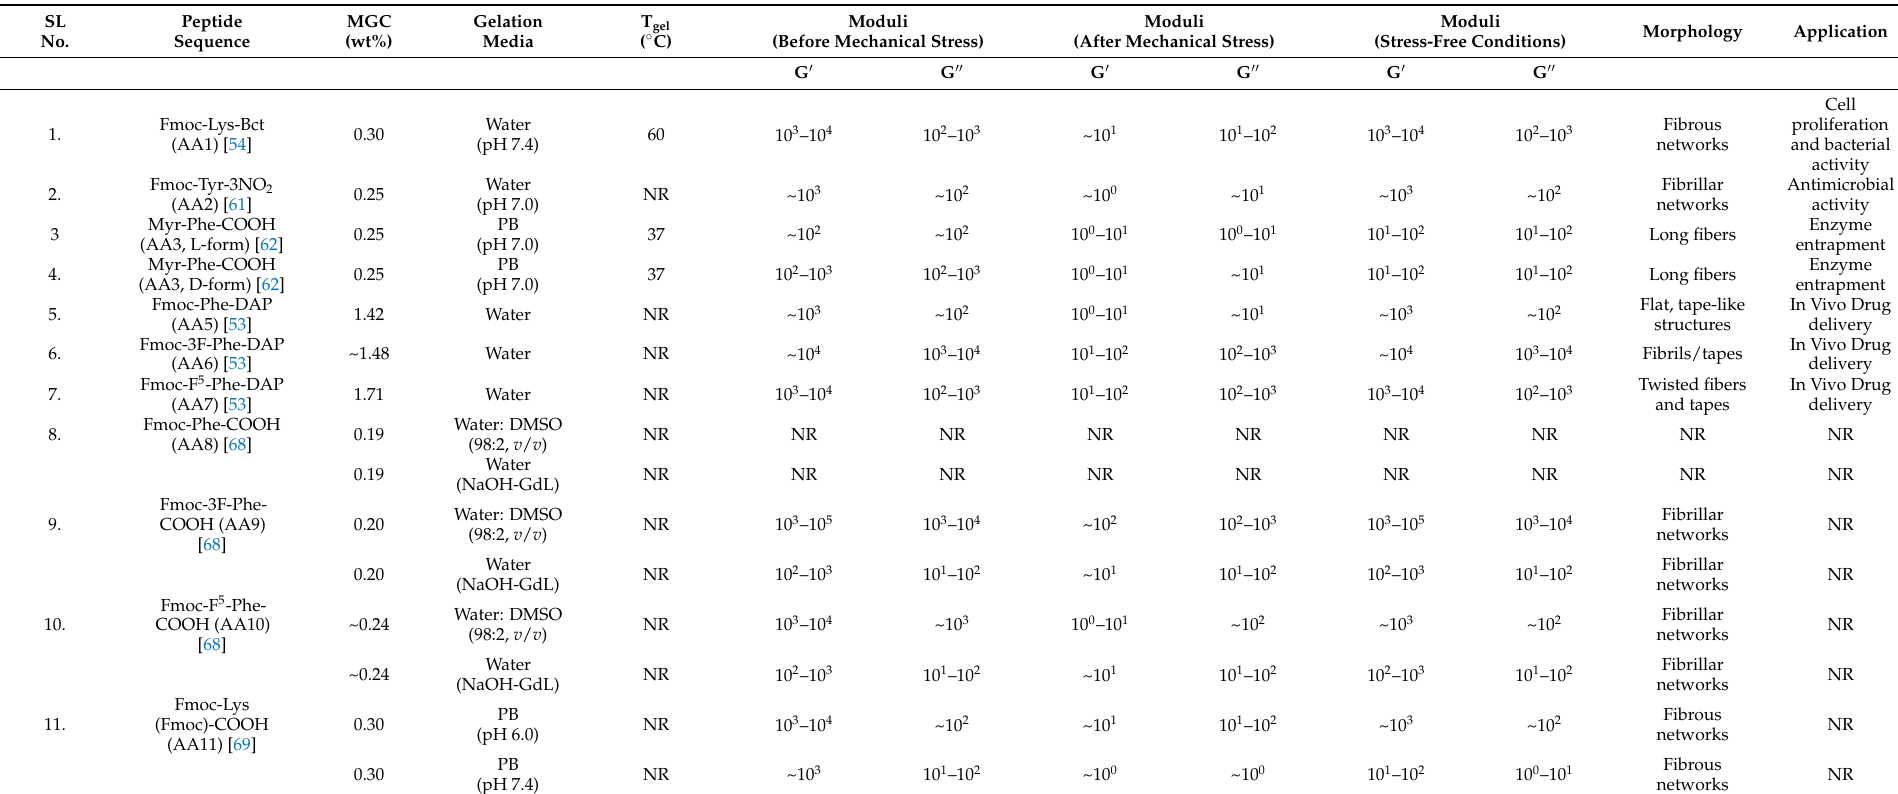
Table 1. List of amino acid (AA)-based thixotropic hydrogelators and respective gelation parameters. SL